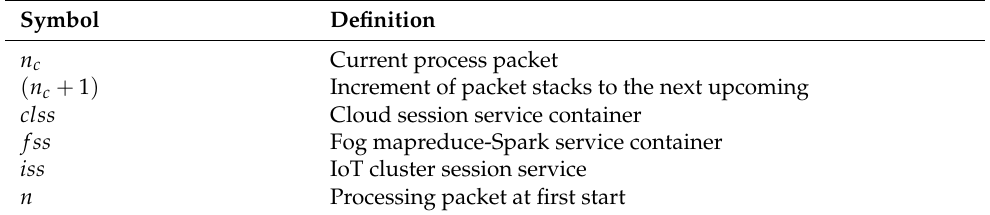
Table 3. Symbols used in the